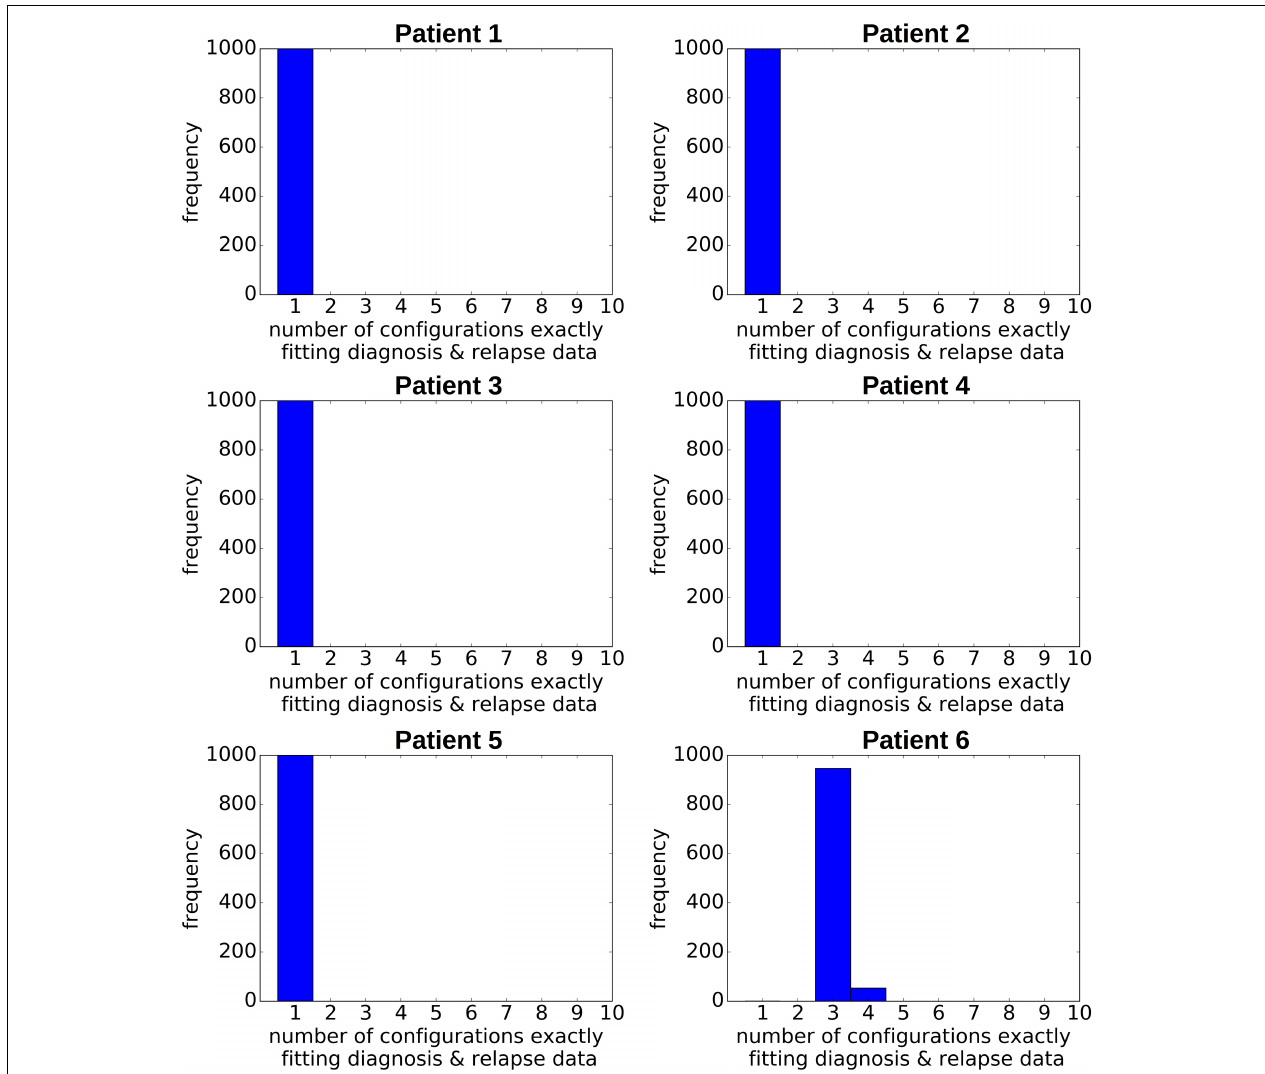
FIGURE 5 | Impact of sampling error on the reconstructed hierarchies. For each patient, we generate 1,000 random pairs of diagnosis and relapse samples from a multivariate distribution. The probabilities of the multivariate distribution equal the clonal frequencies in the single cell data. The size of the samples equals the number of sequenced leukemic cells. We recorded for each pair of randomly generated diagnosis/relapse samples the number of clonal hierarchies compatible with the resampled diagnosis and relapse data. The vertical axis shows how many of the 1,000 samples were compatible with 1, 2, 3, ... hierarchies,